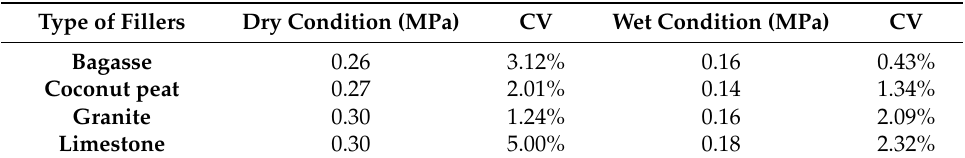
Table 9. Indirect tensile strength (ITS) of dry and wet conditions on asphalt mixtures with granite and di ff erent filler content.